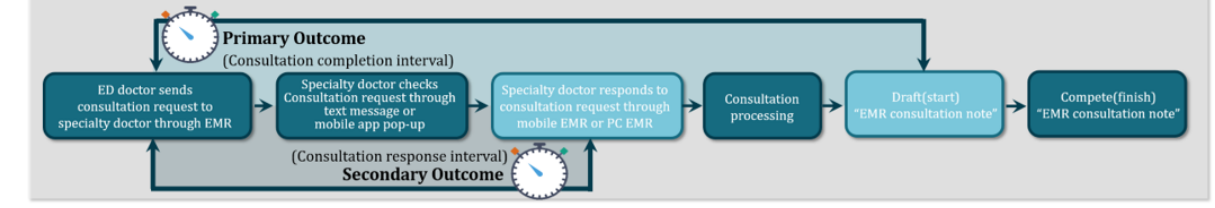
Figure 1. The specialty consultation process flow and outcome measurement of the study. The primary outcome was a measurement of the interval between consultation request and draft consultation note, while the secondary outcome used the interval between consultation request and response. ED: emergency department; EMR: electronic medical